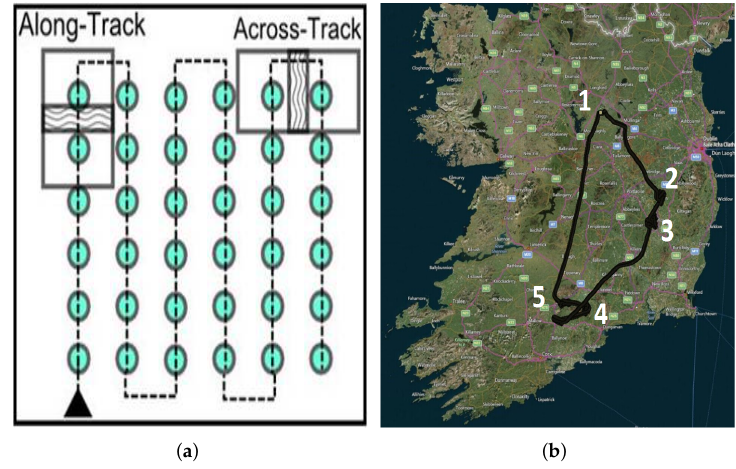
Figure 5. Flight planning for aerial surveys ( a ) blue circles and dashed line represent image capture locations and flight path. The optimal along- and across-track overlap varies depending on the flying height, terrain type and sensor field of view (FOV) and identifying a suitable overlap is essential for increasing the number of matching features in overlapping imagery; ( b ) the navigation track from the initial test flight overlaid on a map of Ireland—five geographically distributed test sites were surveyed in a single flight using dedicated RPAS sensors, with four different high resolution datasets captured at each